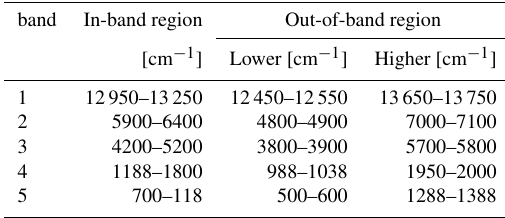
Table 4. In-band and out-of-band